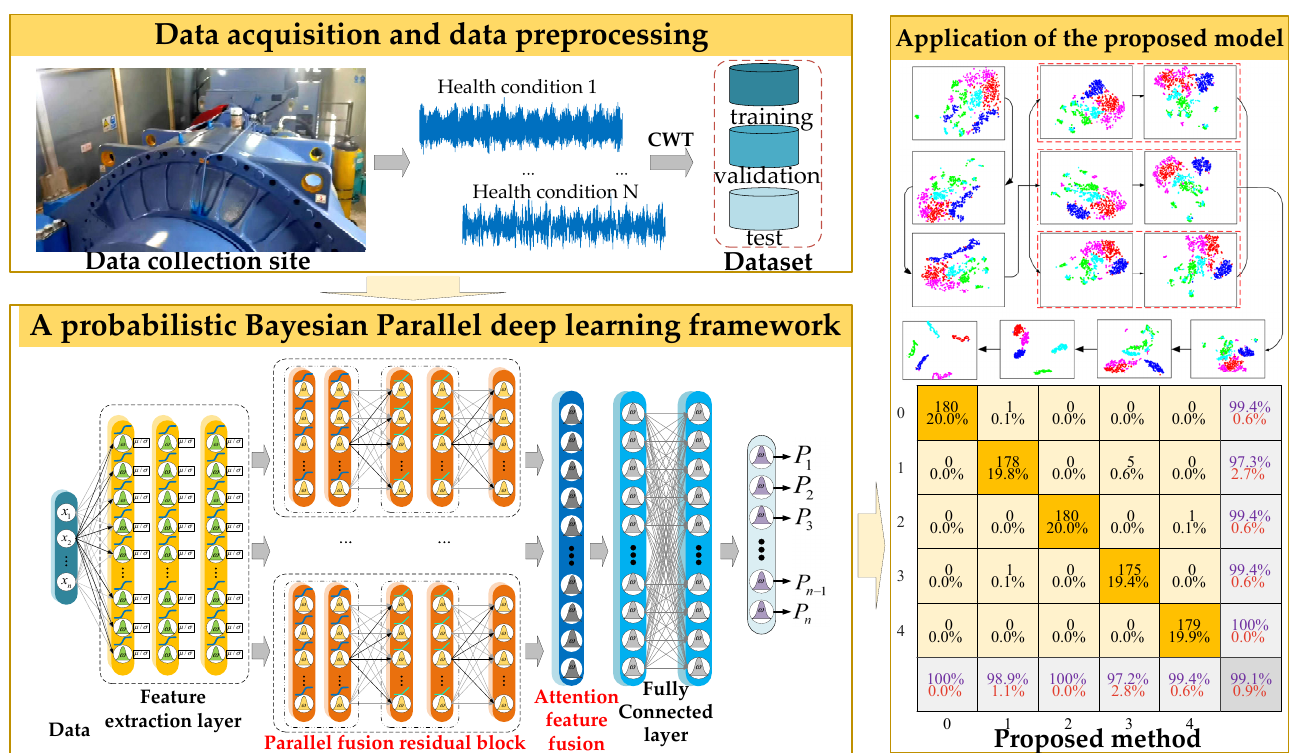
Step 4: The training dataset trains the training network. The test dataset evaluates the fault diagnosis of wind turbines. The overall process of the proposed method is shown in confidence of the decisions given by the diagnostic model, resulting in a confident diagnosis. Figure 3.